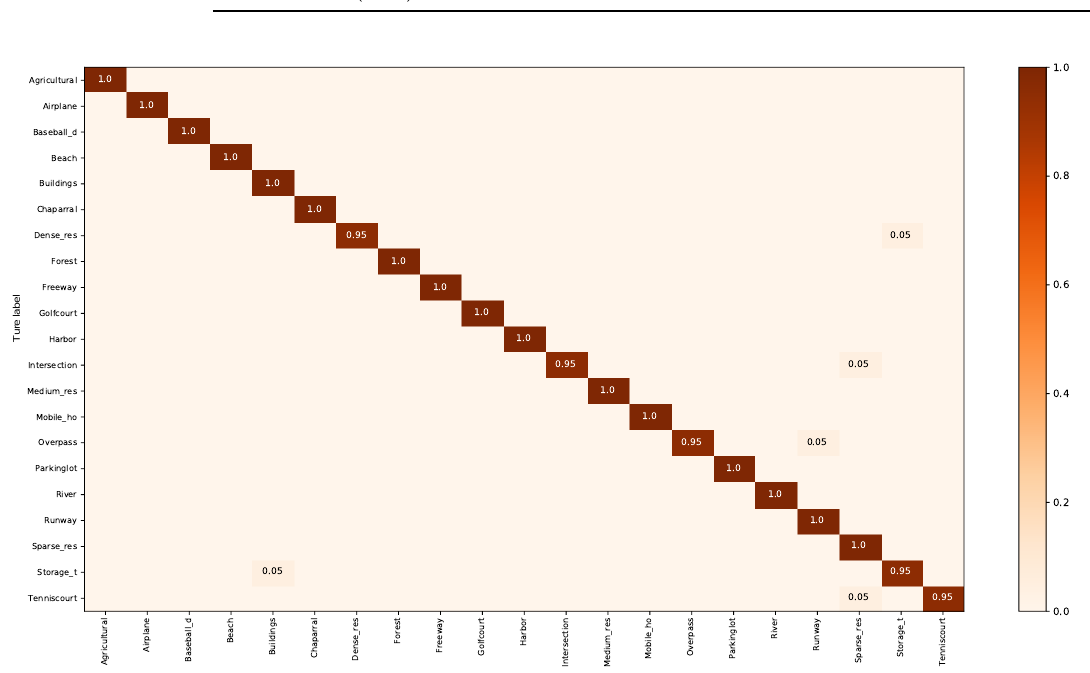
Figure 11. CM of the UCM dataset for an 80% training ratio (only displays results greater than